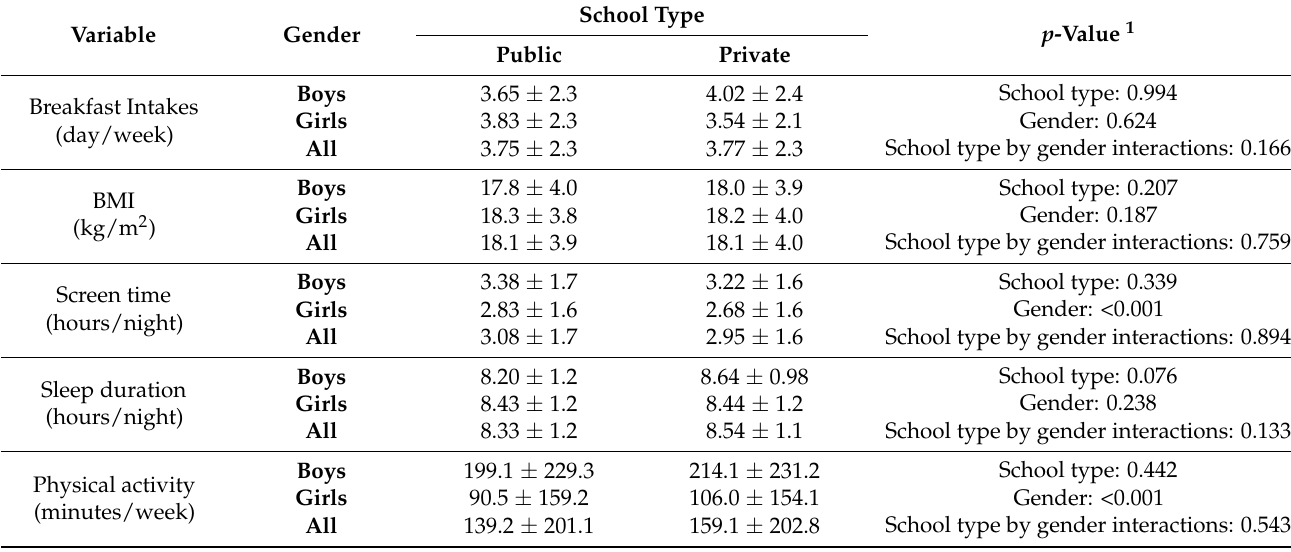
Table 3. Multivariable analysis for selected breakfast, body mass index (BMI), and lifestyle variables while controlling for age and socio-demographic factors stratified by gender and school type (public versus